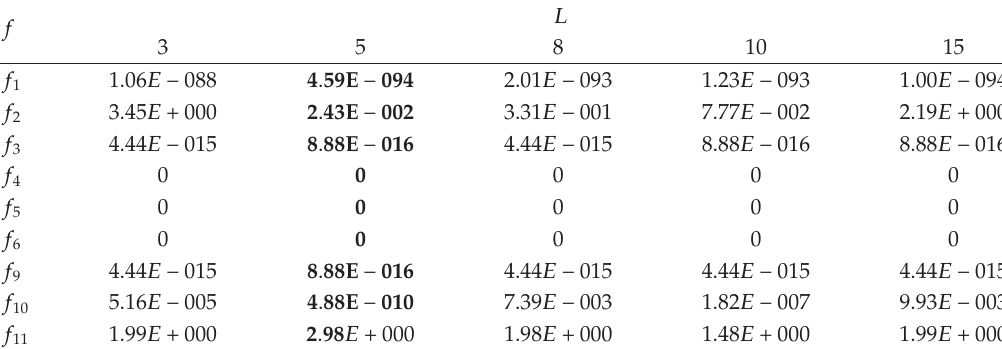
Table 3: Parameter tuning of the regrouping period (cid:2) L (cid:3) .